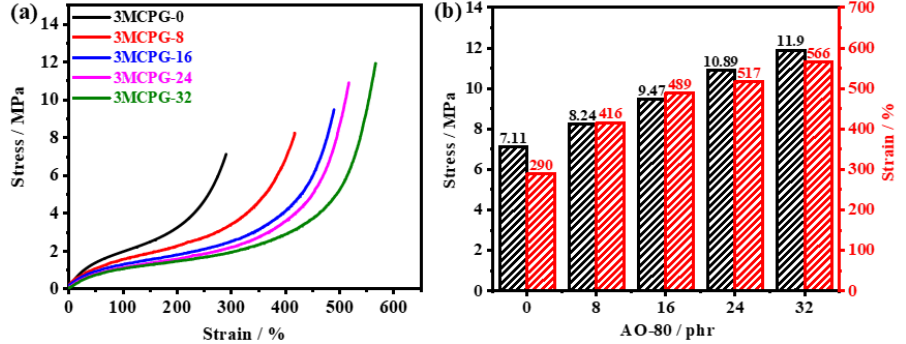
Figure 9. ( a ) Mechanical properties of the MPU/AO ‐ 80 composites. ( b ) Histogram of the mechanical parameters of the MPU/AO ‐ 80 composites.